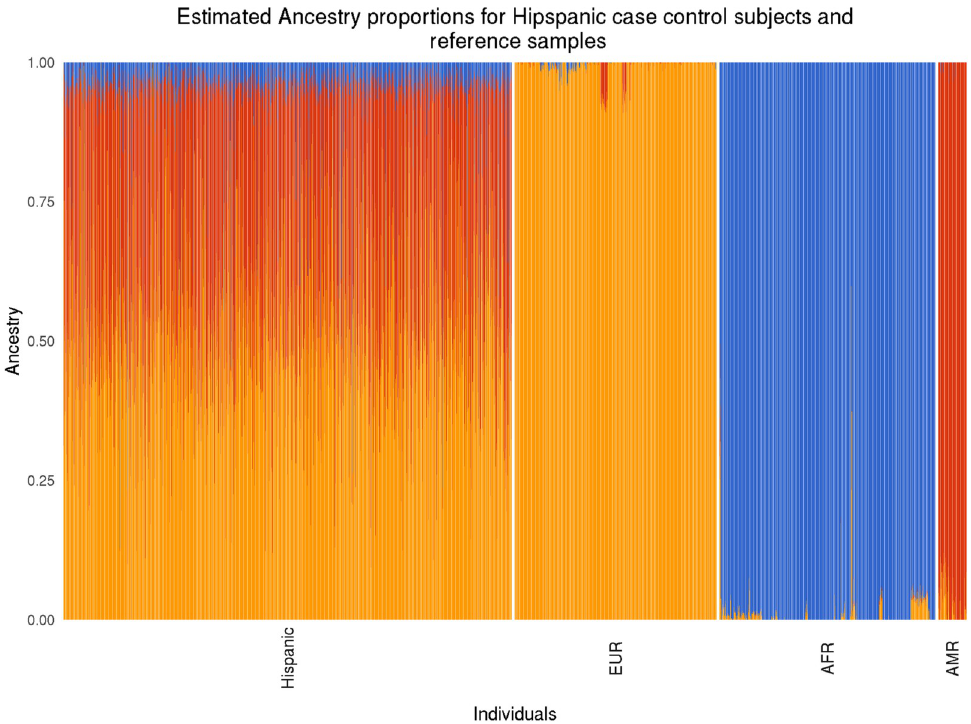
Fig 2. Estimated ancestry proportions for query Latino subjects and reference samples: Partition of global ancestries into three components: European ancestry (orange), African ancestry (blue) and Amerindian ancestry (red). Latino, CCRLP Latino pilocytic astrocytoma cases and controls; EUR, reference subjects of European ancestries; AFR, reference subjects of African ancestries; AMR, reference subjects of Amerindian ancestries.